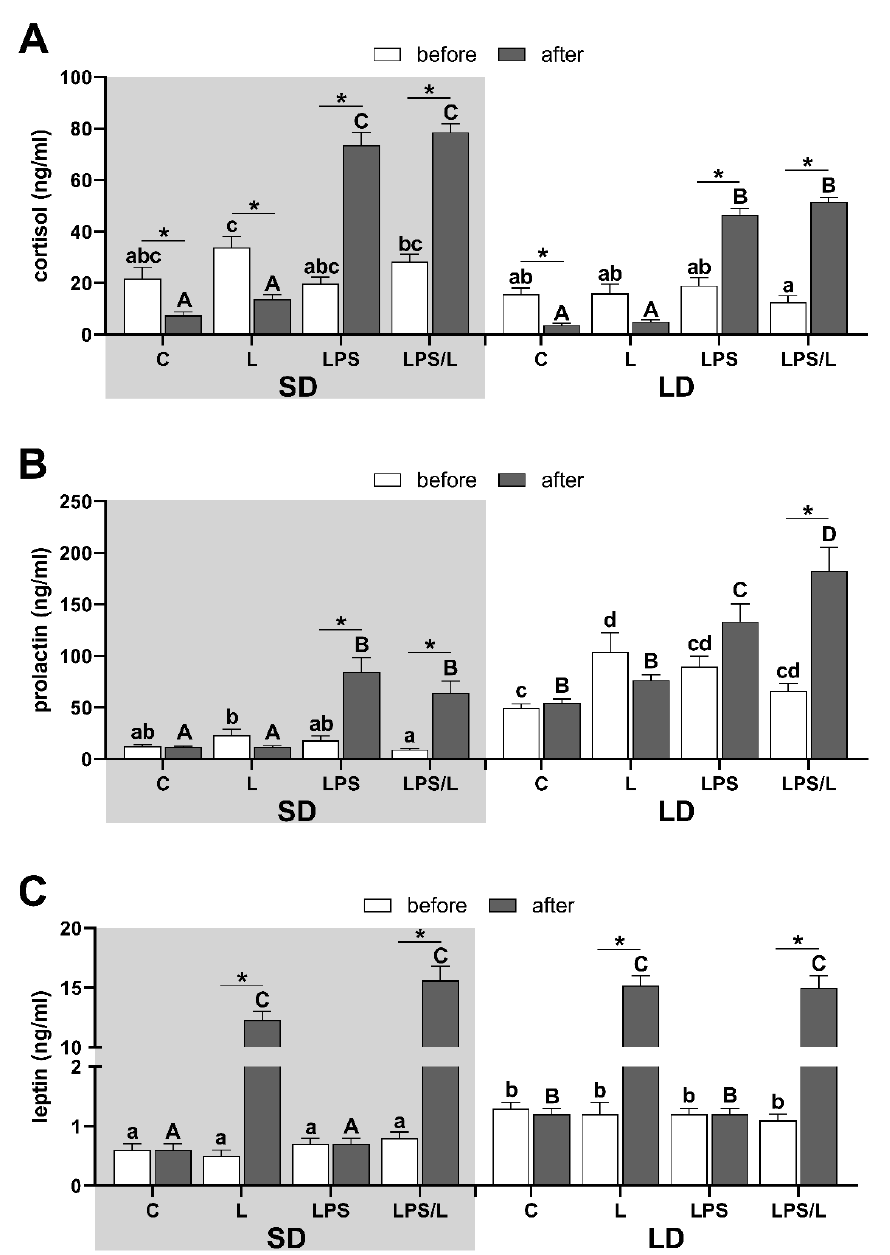
Figure 1. The overall mean ( ± SEM) concentration of cortisol ( A ), prolactin ( B ) and leptin ( C ) in blood plasma during the short days (SD, grey background) and the long days (LD, white background) in control (C), leptin-injected (L), lipopolysaccharide-injected (LPS) and LPS- and leptin-injected (LPS / L) groups, collected before (white bars) and after LPS / leptin / saline treatments (dark bars). Significant di ff erences at p < 0.05, were indicated by: *—for treatment e ff ect within the groups (repeated measures ANOVA—Sidak’s post hoc test) and by di ff erent letters for the photoperiod and treatments e ff ects calculated separately for data before treatments (abcd—lowercase letters) and after treatments (ABCD—uppercase letters) by LPS / leptin (two-way ANOVA-Tukey’s post hoc